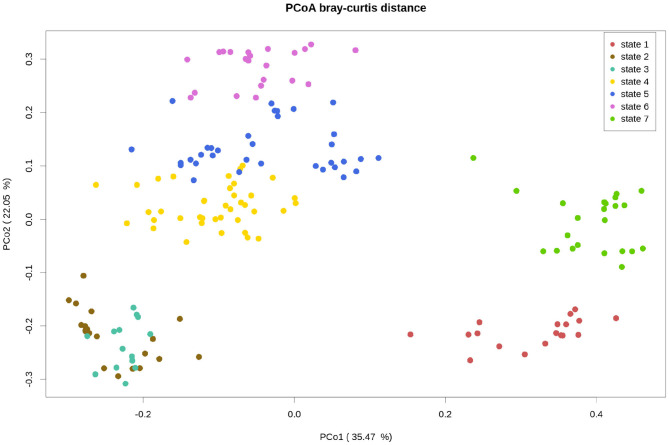
Principal component analysis based on the Bray-Curtis distance of the bacterial communities (genus level) at stable states. The two first coordinates PCo1 and PCo2 explain 35.47 and 22.05% of the variance, respectively. The plots of the three first coordinates are provided in Supplementary Figure 4.